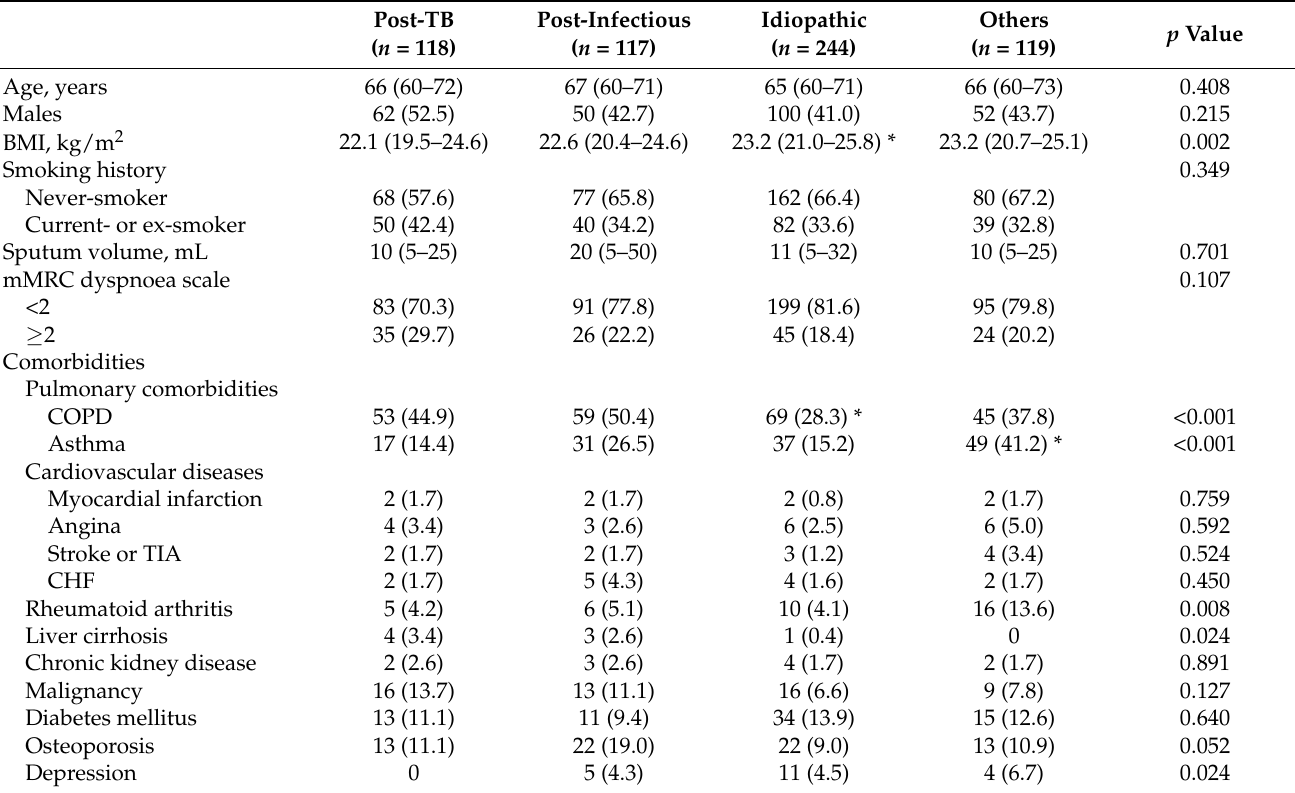
Table 1. Baseline characteristics of the study population.